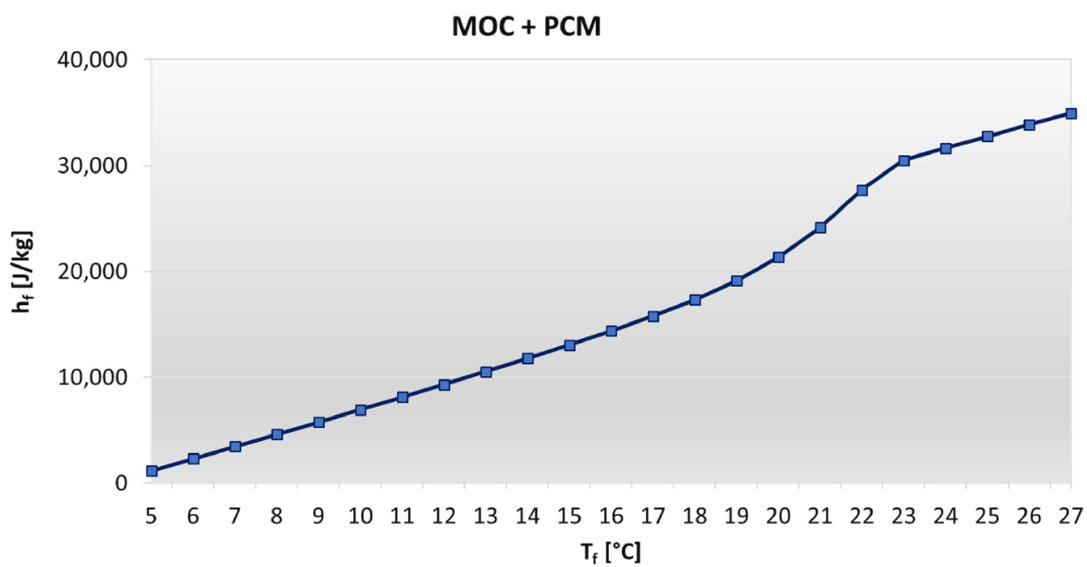
Table 4. Enthalpy–temperature function of MOC with Micronal PCM.